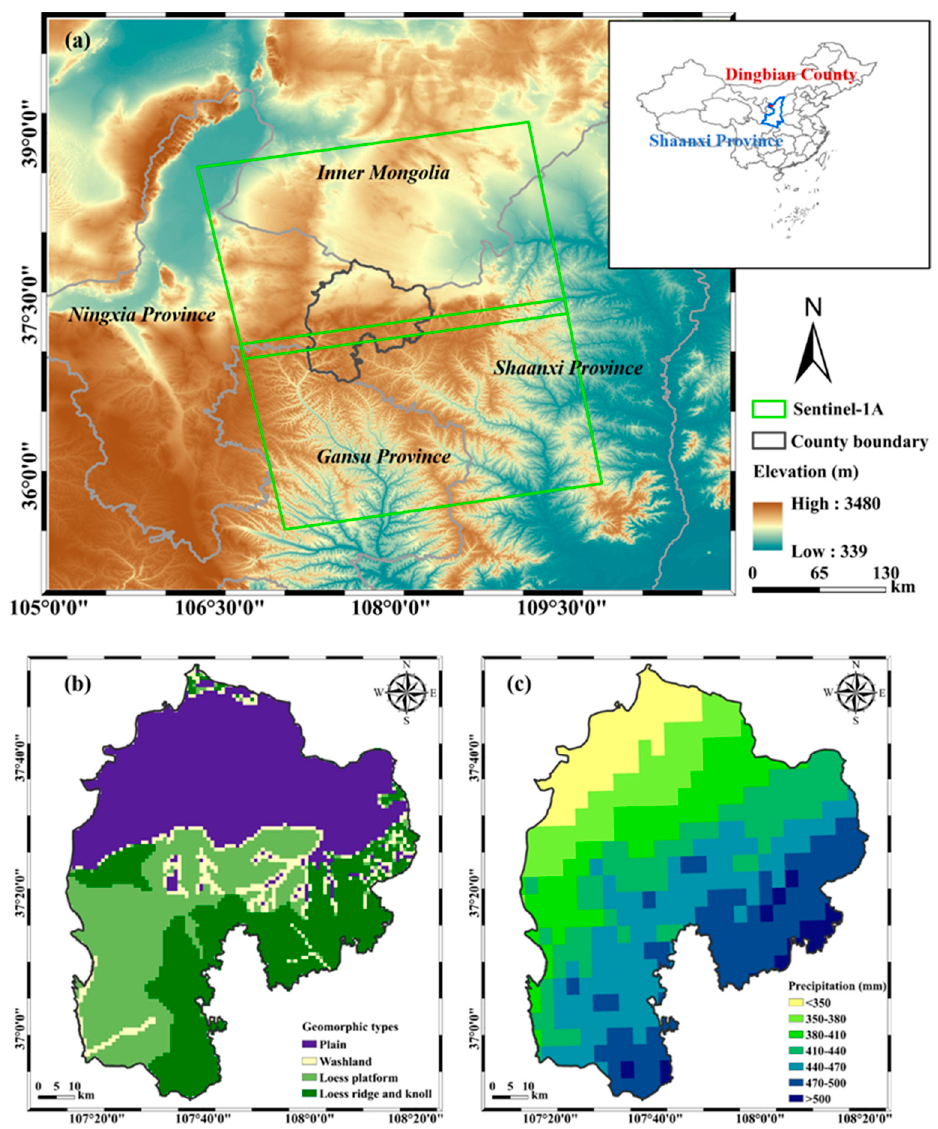
Figure 1. ( a ) The study area and the coverage of ascending Sentinel-1A datasets. The background is obtained from the shuttle radar topography mission (SRTM) digital elevation model (DEM), with inset showing the location of the study area in China. ( b ) Typical geomorphic-types map and ( c ) annual-average precipitation map of the study area.